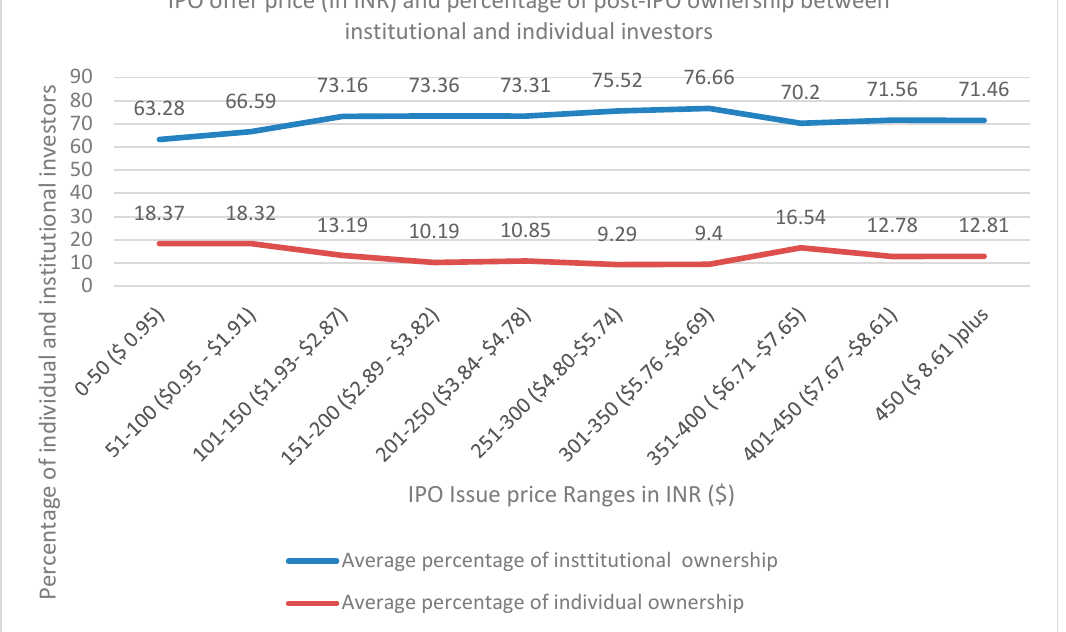
Figure 2. IPO offer price: mean institutional and individual holding after the IPO (2006–2015). (As per Indian regulations, the quarterly reports of listed Indian companies must specify their underlying ownership in terms of both the absolute number and percentage. The percentage of individual and institutional investors is assessed at the end of the first monthly quarter immediately after the IPO listing). Source—CIMIE Prowess IQ database. The UDS $ conversation rate is the average rate (INR-$) between 2006–2015. (Source-RBI forex).